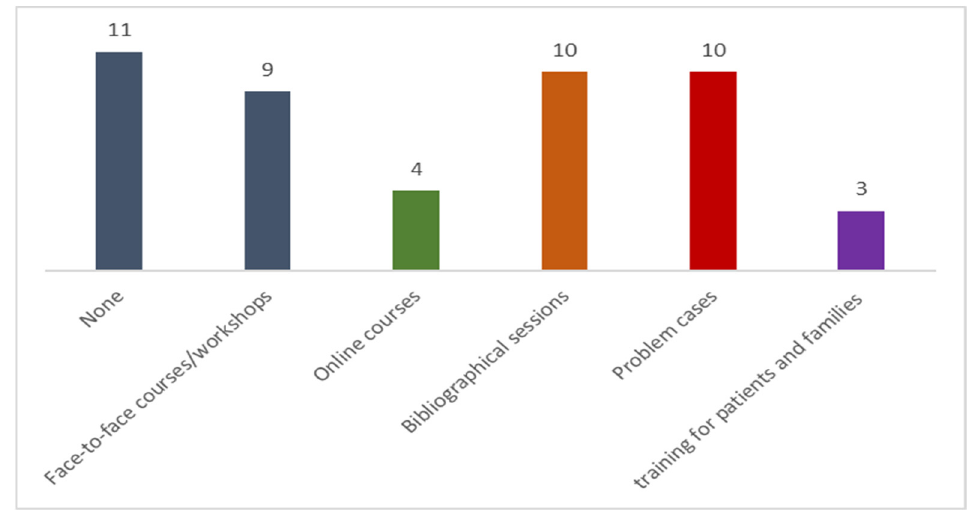
Figure 2. PROA training activities at the hospitals participating in the VINCat pediatric PROA (n = 26).